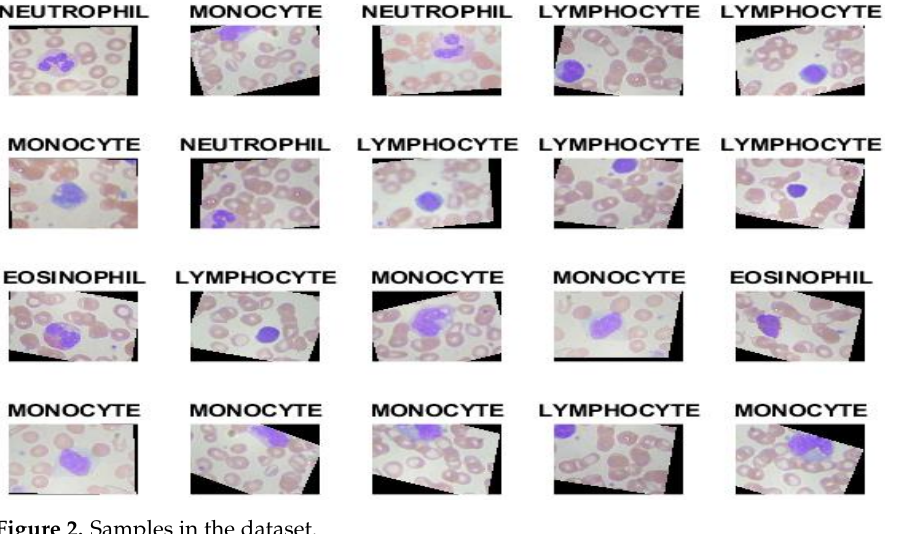
Figure 2. Samples in the dataset.